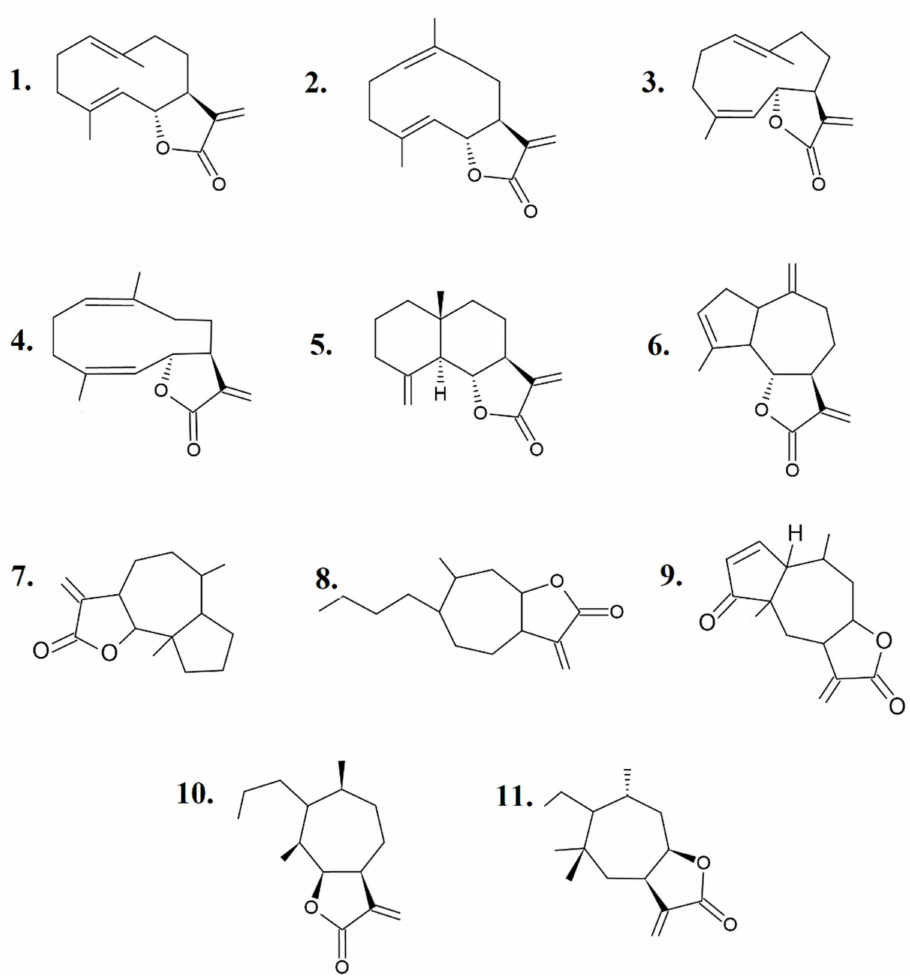
Figure 1. Skeletons of sesquiterpene lactones: Germacrolide ( 1 ), Melampolide ( 2 ), Heliangolide ( 3 ), cis , cis -Germacradienolide ( 4 ), Eudesmanolide ( 5 ), Guaianolide ( 6 ), Ambrosanolide ( 7 ), Xanthanolide ( 8 ), Helenanolide ( 9 ), Secoambrosanolide ( 10 ), and Secohelenanolide ( 11